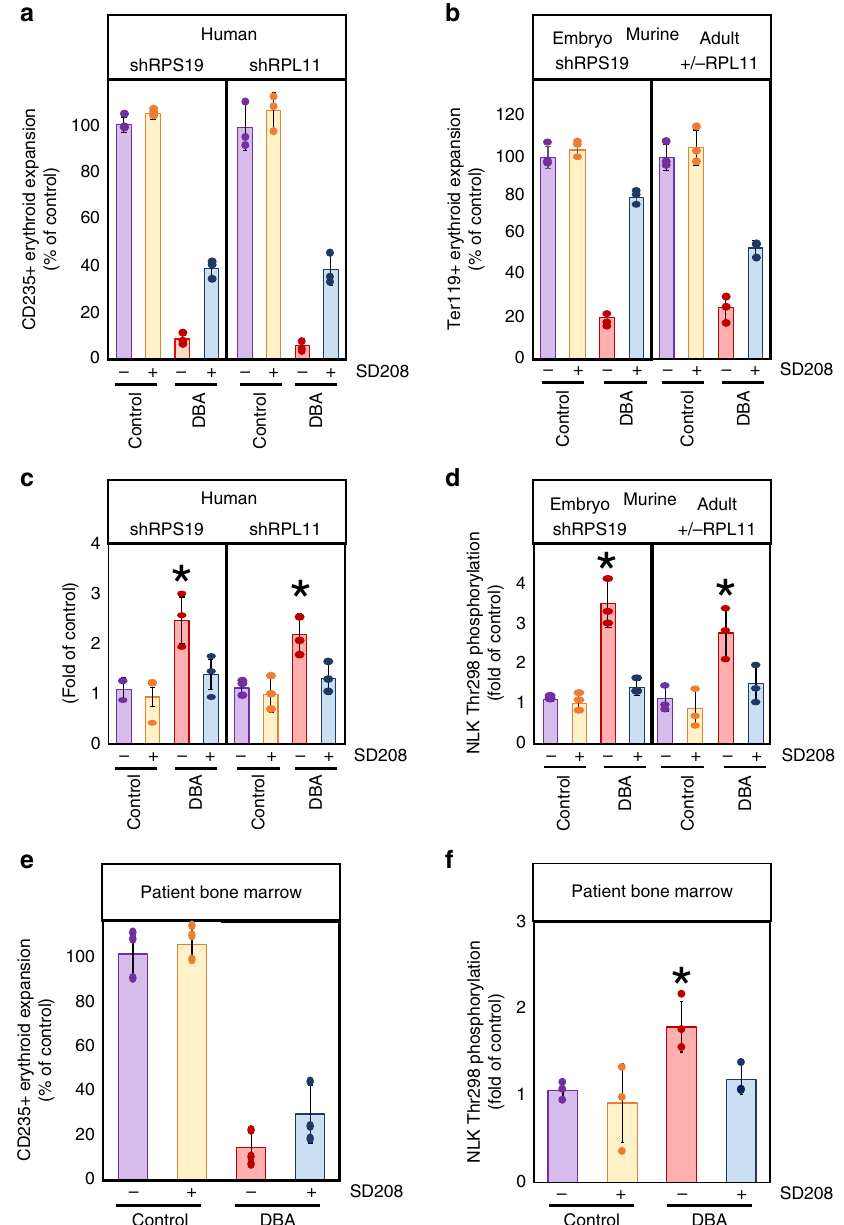
Fig. 8 NLK inhibition increases expansion of erythroid progenitors from human and murine models of DBA. a Human cord blood CD34 + progenitors were transduced with lentivirus co-expressing GFP with shRNA against luciferase (shLuc), RPS19 (shRPS19), or RPL11 (shRPL11). After 36 h GFP + cells were differentiated in erythroid media in the presence or absence of 5 µ M SD208 for 15 days. Cells were counted and assessed for cell surface expression of CD235. b Lin-Kit + hematopoietic progenitors were obtained from three mouse embryos expressing tetracycline-inducible shRNA against RPS19 at day E14.5 or three untreated mice, and thee mature RPL11 + / + or three mature RPL11 + /lox mice treated with tamoxifen for eight weeks. Cells were grown in the presence or absence of doxycycline and/or SD208 for 8 days prior to counting and assessing for Ter119 surface expression. Values were expressed as a percentage relative to untreated controls. c , d Intracellular phosphorylation of NLK at Thr298 was determined by capillary electrophoresis using the Peggy Sue ™ Automated Western blotting platform. After lysis, 4 µ g of protein from the CD235 + population was probed against pThr298-NLK and normalized to GAPDH. Detected NLK phosphorylation is plotted relative to untreated control. e CD34 + HSPCs were isolated from three healthy control and three DBA patient mononuclear bone marrow aspirates by magnetic bead sorting and differentiated in the presence or absence of SD208 for 14 days. After counting the total cell population, the ratio of CD235 + erythroblasts was determined by fl ow cytometry and number of CD235 + erythroblasts calculated. This was expressed as a percentage of the average number of erythroid cells present in untreated healthy controls. f NLK phosphorylation was assessed by capillary electrophoresis as above. Bars represent means± SD with individual data points overlaid. Purple depicts untreated controls, yellow depicts controls treated with SD208, red depicts untreated DBA progenitors, while blue depicts DBA progenitors treated with SD208. n = 3 independent experiments performed in triplicate. Statistics: two-tailed Student ’ s t test, signi fi cant * p < 0.05. Also see Supplementary Fig. 8. Source data are provided as a Source Data fi